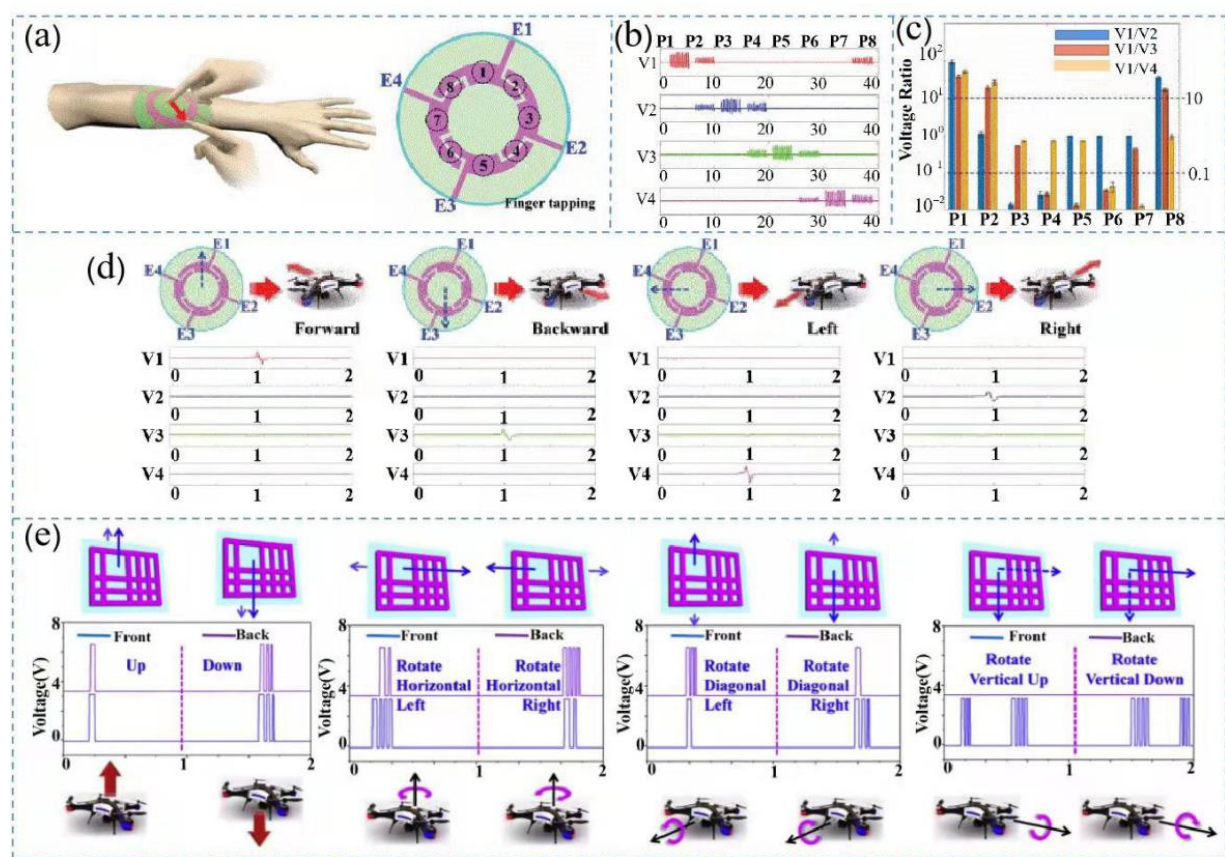
Figure 8. Virtual UAV control based on TENG: ( a ) triboelectric patch attached to the skin of a human arm; ( b , c ) output signals corresponding to finger tapping and sliding of the patch; ( d ) triboelectric patch controlling signal output corresponding to the horizontal movement of the UAV, Reprinted with permission from ref. [104]. Copyright 2020 IEEE; and ( e ) corresponding signal output of the UAV when it moved through 3D space. Reprinted with permission from ref. [40]. Copyright 2019 Nano Energy.